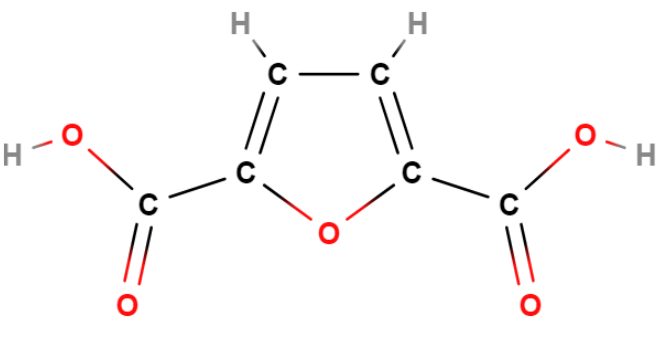
Figure 11. Structure of FDCA (C 6 H 4 O 5 ).